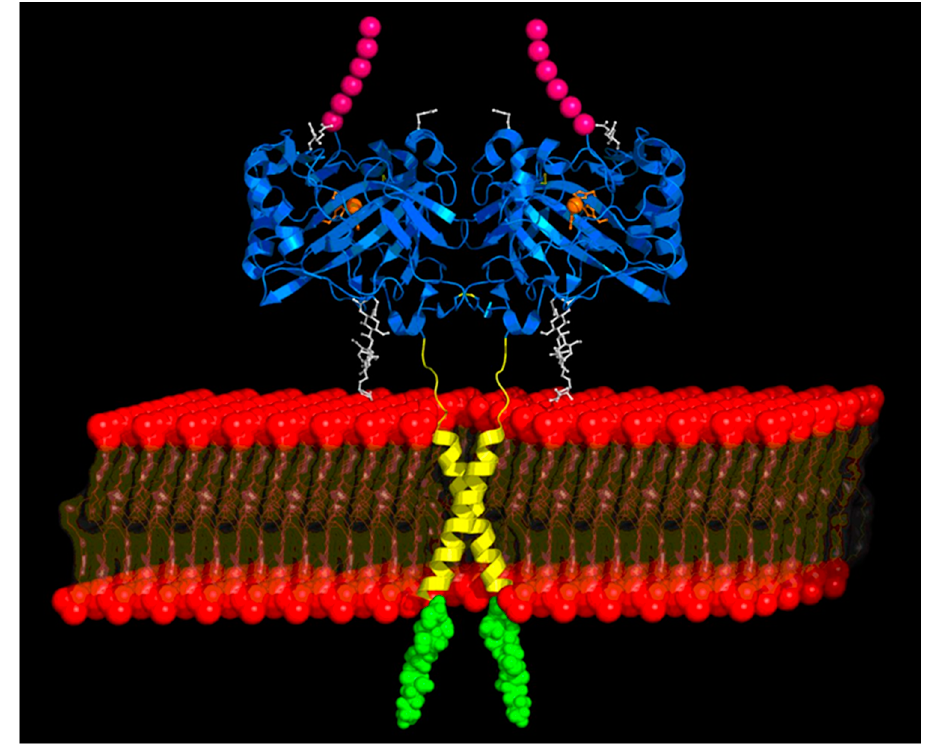
Figure 3. CA IX X-ray crystal structure of the catalytic domain (in blue), the PG domain (cartoon in pink), plasma membrane (in red), the transmembrane domain in yellow (modeled) and the intracytosolic tail (modeled, in green) [29].